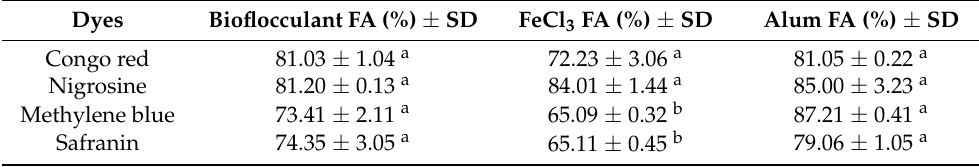
Table 9. Dye removal efficiencies of the bioflocculant from P. kudriavzevii MH545928.1. Dyes Bioflocculant FA (%) ± SD FeCl 3 FA (%) ± SD Alum FA (%) ± SD Congo red 81.03 ± 1.04 a 72.23 ± 3.06 a 81.05 ± 0.22 a Nigrosine 81.20 ± 0.13 a 84.01 ± 1.44 a 85.00 ± 3.23 a Methylene blue 73.41 ± 2.11 a 65.09 ± 0.32 b 87.21 ± 0.41 a Safranin 74.35 ± 3.05 a 65.11 ± 0.45 b 79.06 ± 1.05